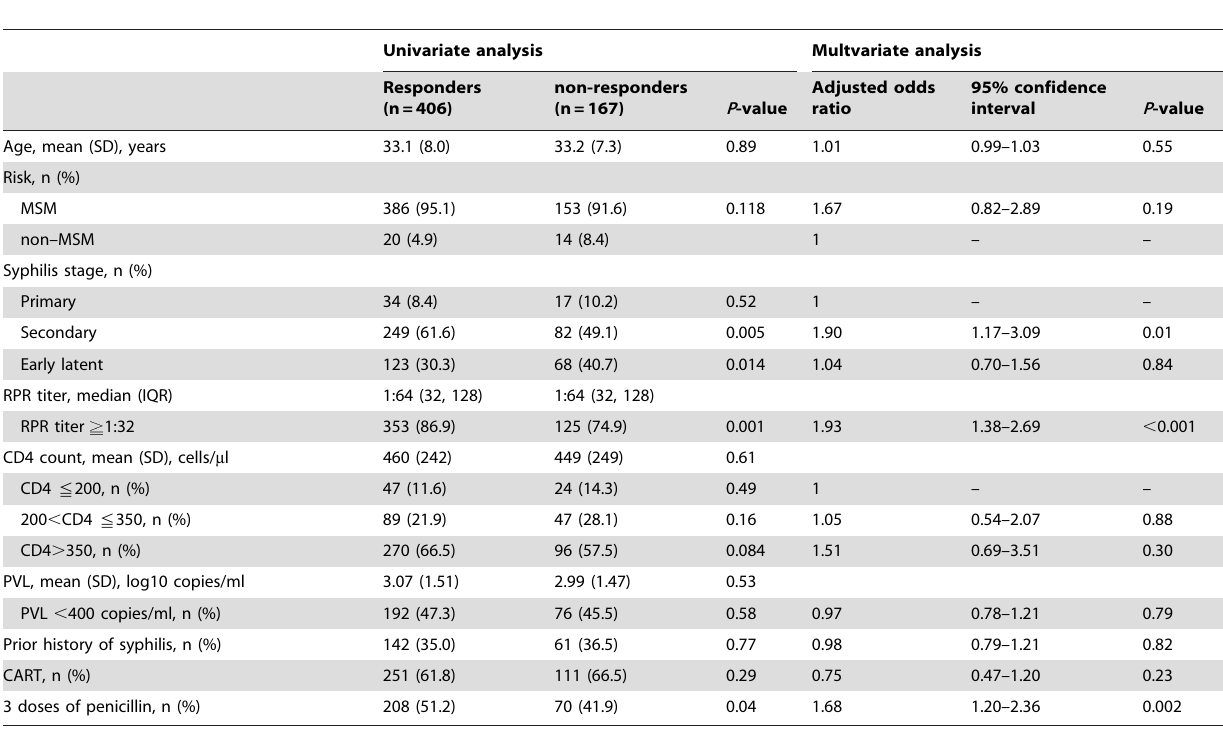
Table 2. Factors associated with serological response in the patients who received 1 dose or 3 doses of benzathine penicillin G at 12 months of follow-up in univariate and multivariate analysis.